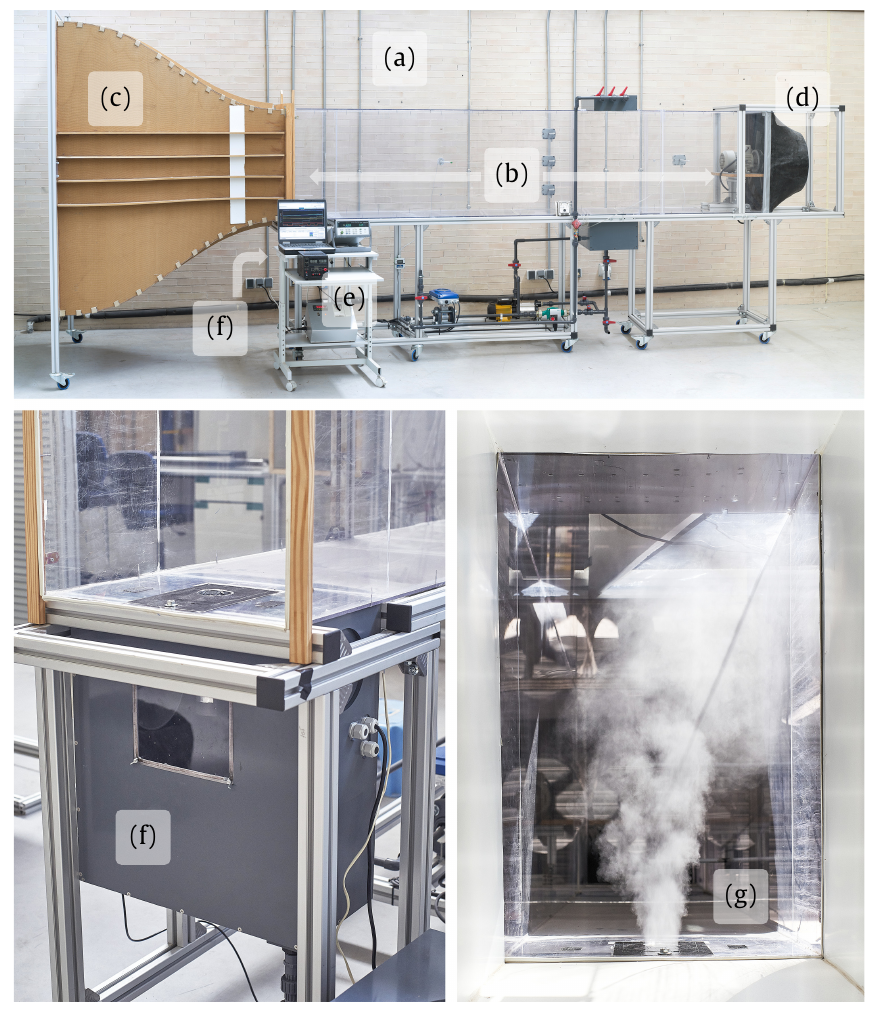
Figure 2. Subsonic wind tunnel facility employed in the experimental tests: ( a ) subsonic wind tunnel; ( b ) test section; ( c ) nozzle; ( d ) diffuser; ( e ) data acquisition system; ( f ) ultrasonic mist generator; and ( g ) structure of water mist stream.